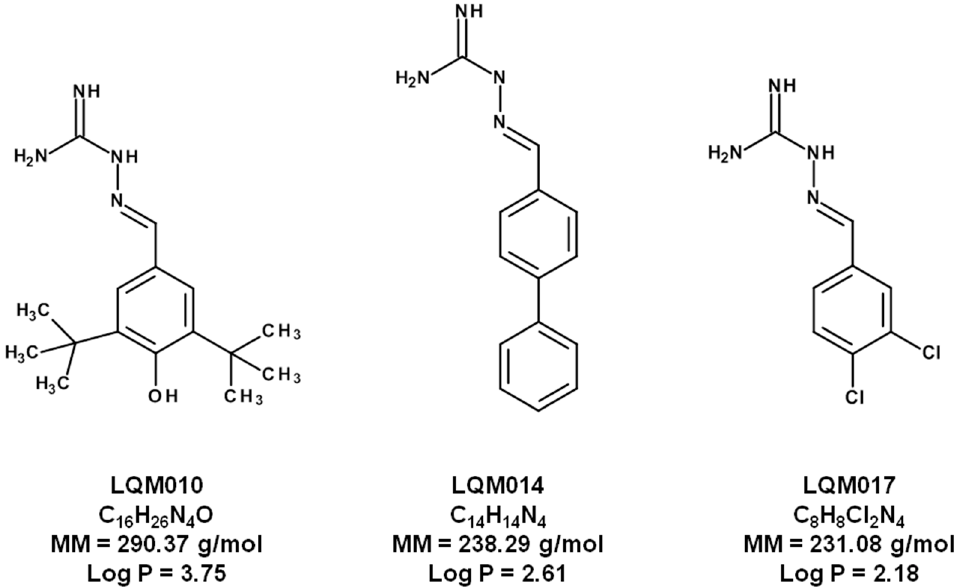
Figure 1. Chemical structures, molecular masses (MM) and partition coefficients (log P ) of the guanylhydrazones LQM010, LQM014 and LQM017.